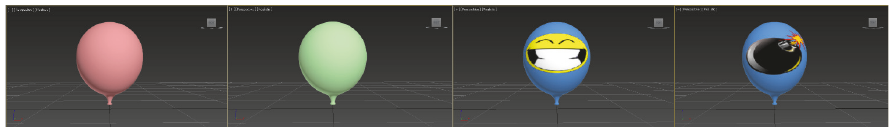
Figure 9: From left to right: an orange balloon that can be popped with a “punch” gesture, a green balloon that can be popped with a “kick” gesture, a smiley (bonus) balloon, and a bomb-type balloon.